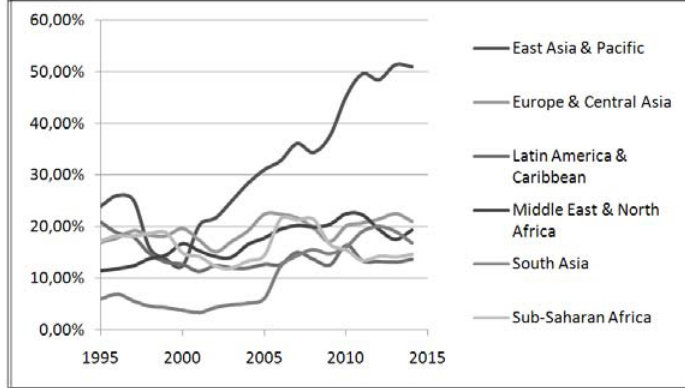
Fig. 3. Trends in ST external debt as a percentage of total gross external debt region-wise